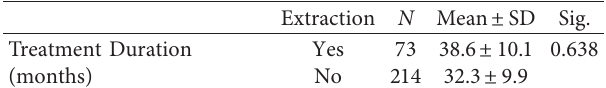
Table 4: Treatment duration with extraction vs. nonextraction treatments.